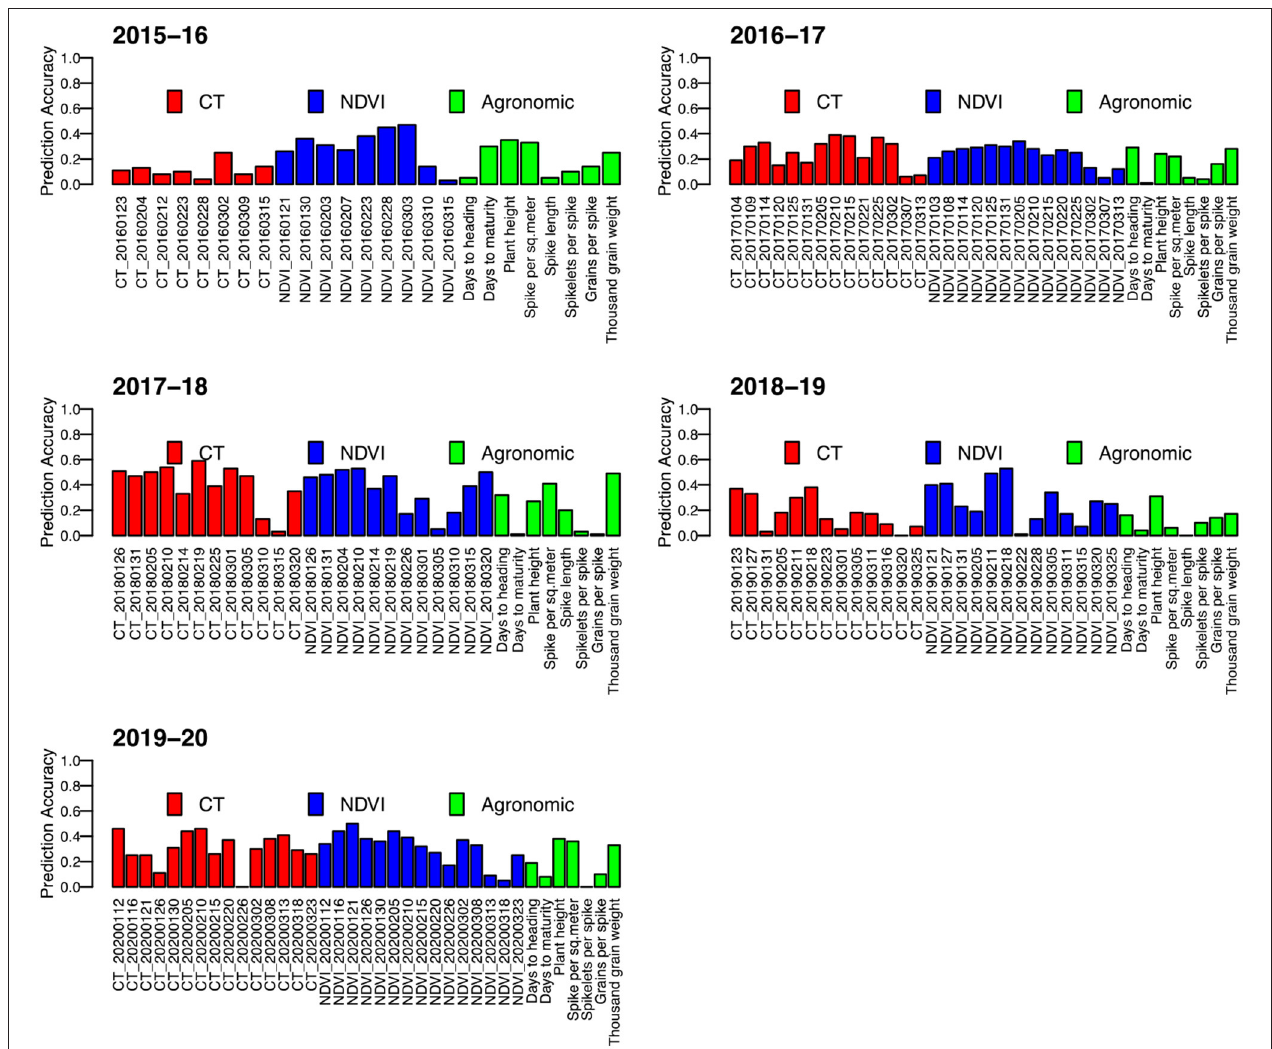
FIGURE 3 | Correlation between predicted grain yield and observed grain yield (prediction accuracy) for five wheat growing seasons in Bangladesh from 2015–16 to 2019–20. Each prediction has been made by using a univariate model with one variable of the phenotypic